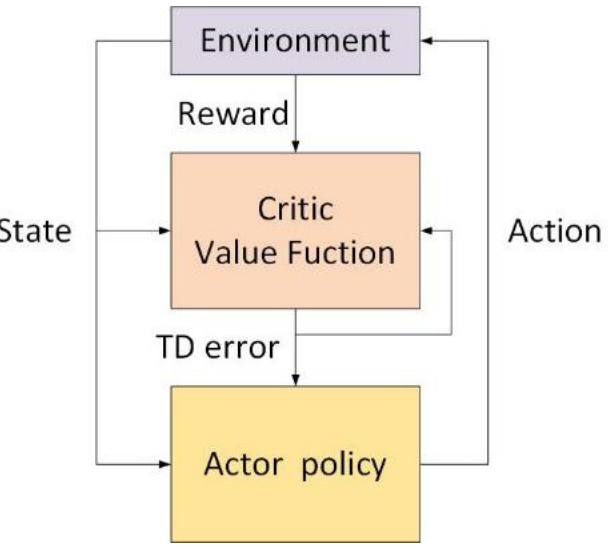
Figure 8. The AC algorithm framework.